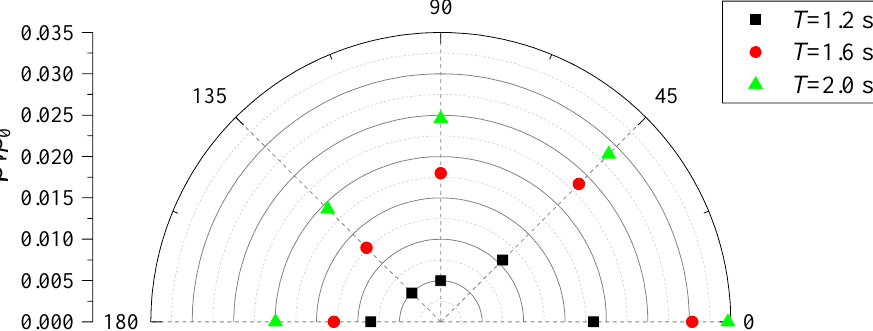
Figure 14. Distribution of the maximum pore-water pressures around the pile for various wave periods at z = − 0.15 m ( H = 16 cm, Points 12, 14, 15, 16, and 18 in Figure 3).